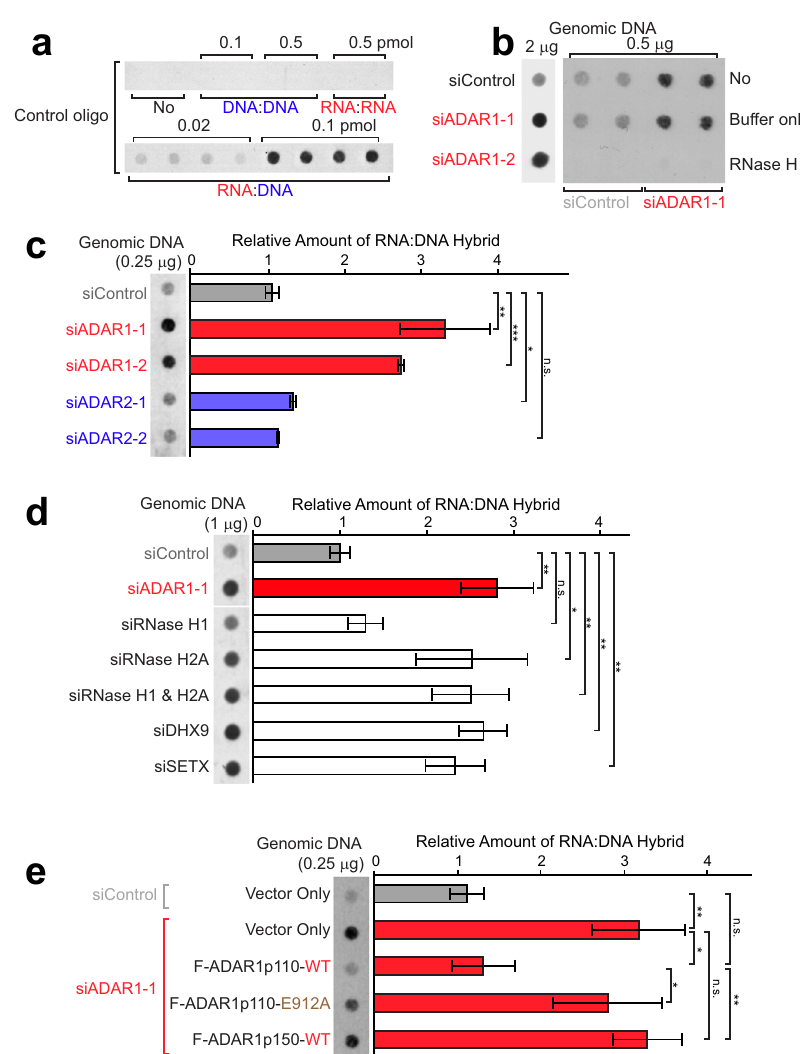
Fig. 2 A-to-I editing activity of ADAR1p110, not ADAR1p150 or ADAR2, is required for suppression of R-loops. a – e Dot blot analysis for RNA:DNA hybrids was conducted using control oligos ( a ) or genomic DNA ( b – e ). a The S9.6 antibody recognized speci fi cally RNA:DNA but not DNA:DNA or RNA: RNA oligo duplex controls. b , c Increased RNA:DNA hybrids were detected only in ADAR1-depleted but not in ADAR2-depleted HeLa cells. b The S9.6 antibody signals were abolished by E. coli -RNase H treatment, con fi rming speci fi c detection of RNA:DNA hybrids. d Comparison of RNA:DNA hybrid levels between depletion of ADAR1 versus depletion of known R-loop regulators. e Increased RNA:DNA hybrid formation resulting from depletion of endogenous ADAR1 was rescued by infection of ADAR1p110-WT (wild type) but not by infection of ADAR1p110-E912A deamination defective mutant or ADAR1p150- WT. c – e Data are mean ± SD ( n = 3, biological replicates); signi fi cant differences were identi fi ed by two-tailed Student ’ s t tests: * P < 0.05, ** P <